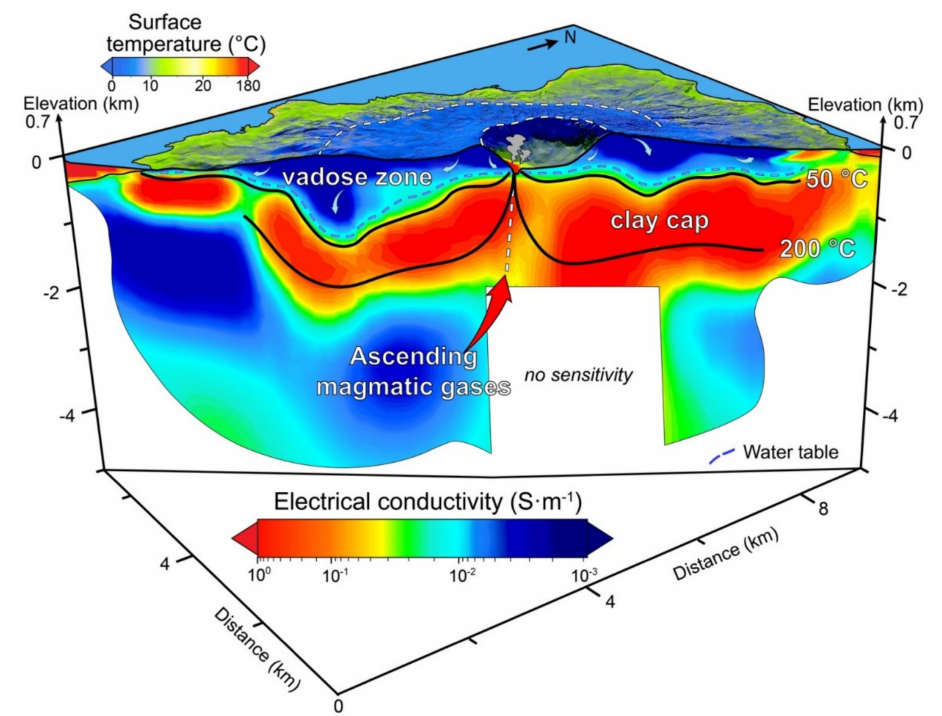
Figure 18. Detection of smectite-rich clay cap at the stratovolcano of Miyakejima Island (Japan). The conductivity profile was retrieved by Gresse et al. [94] using Magnetotellurics. The base of the clay cap corresponds roughly to the end of the stability temperature field of smectite (~200–220 ◦ C). Modified from Gresse et al.